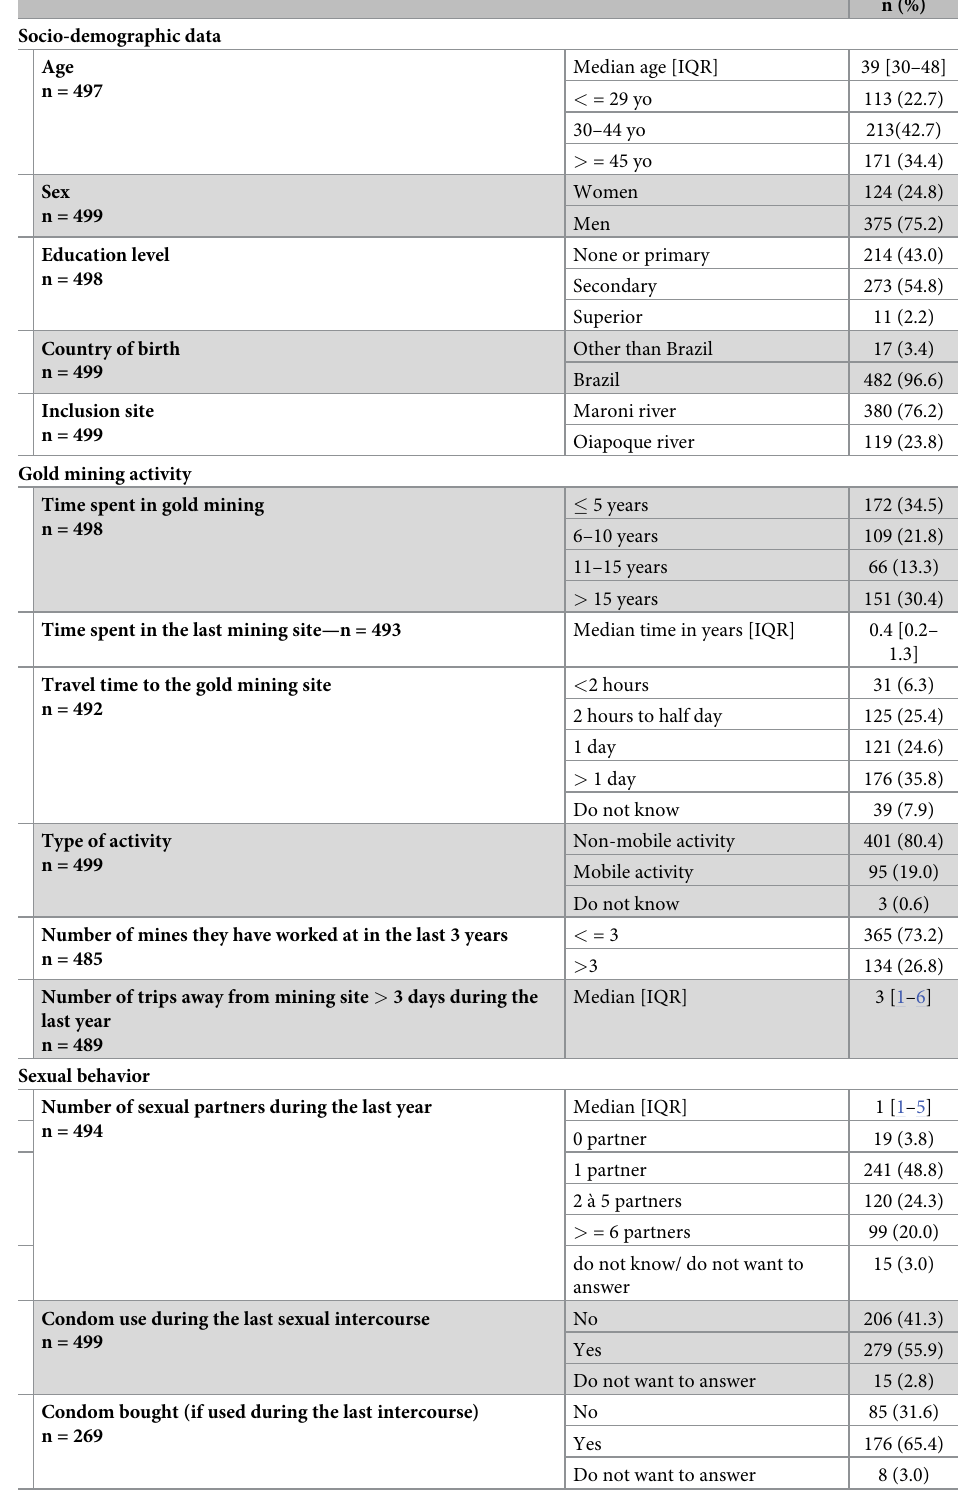
Table 1. Description of the cross-sectional study population, October-December